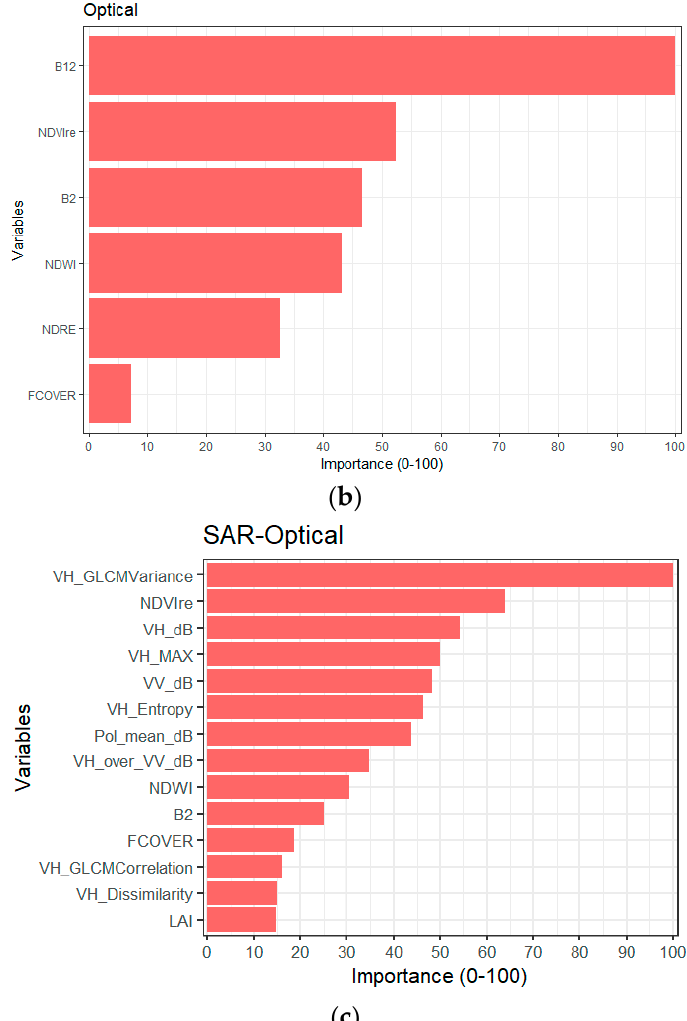
Figure 6. Predictors’ importance for each developed regression model (i.e., ( a ) SAR, ( b ) optical, ( c ) SAR–optical). ( c )